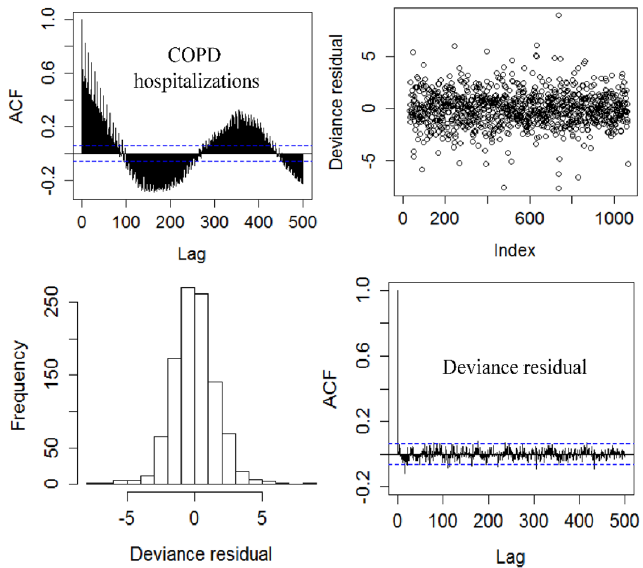
Figure 3. Results of model diagnostics: ACF values for COPD hospitalizations (top left), deviance residual against day of study (top right), histogram of deviance residual (bottom left) and ACF values for deviance residual (bottom right).